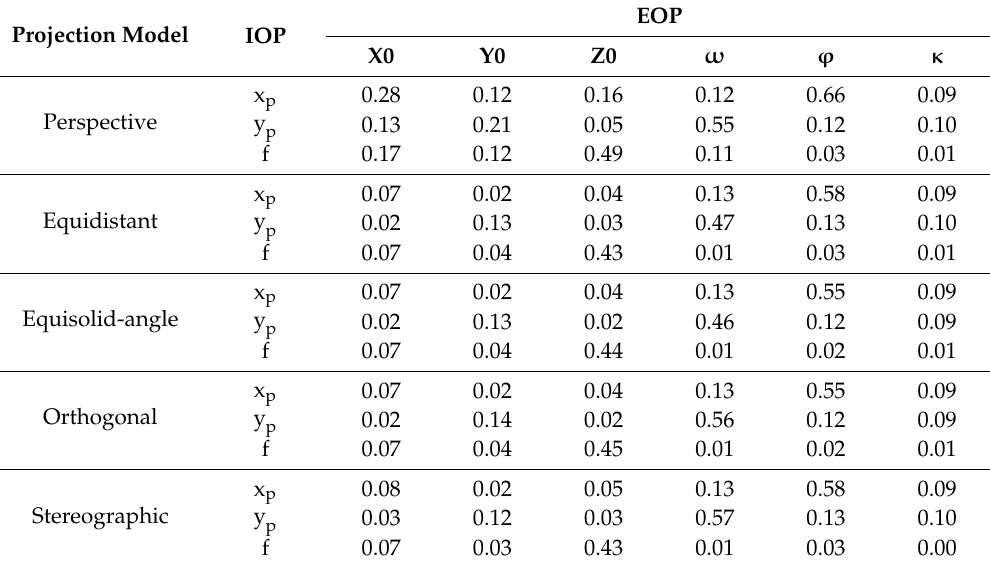
Table 7. Correlation between the orientation parameters (V-type test object).